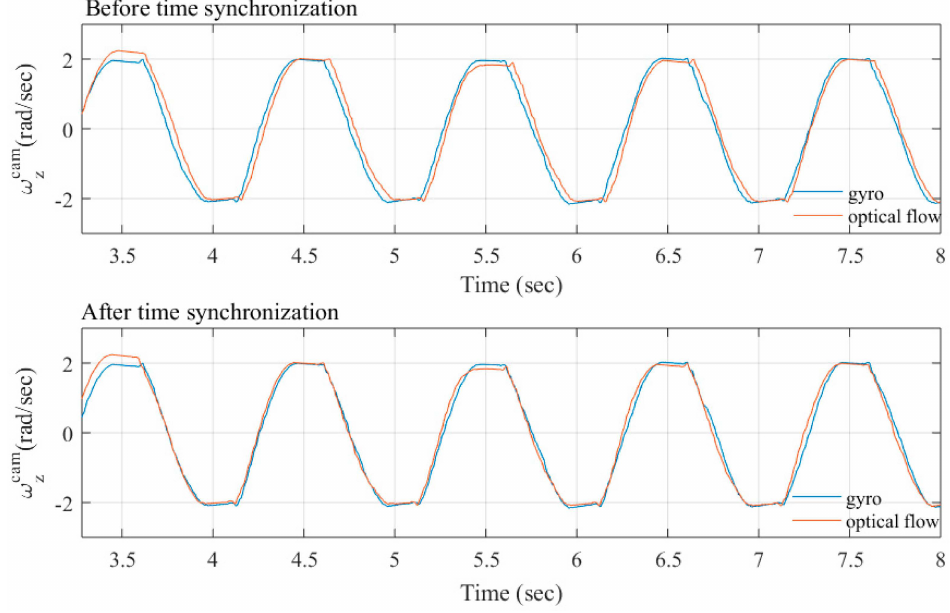
Figure 9. Time synchronization of the camera rotation from the gyroscope and optical